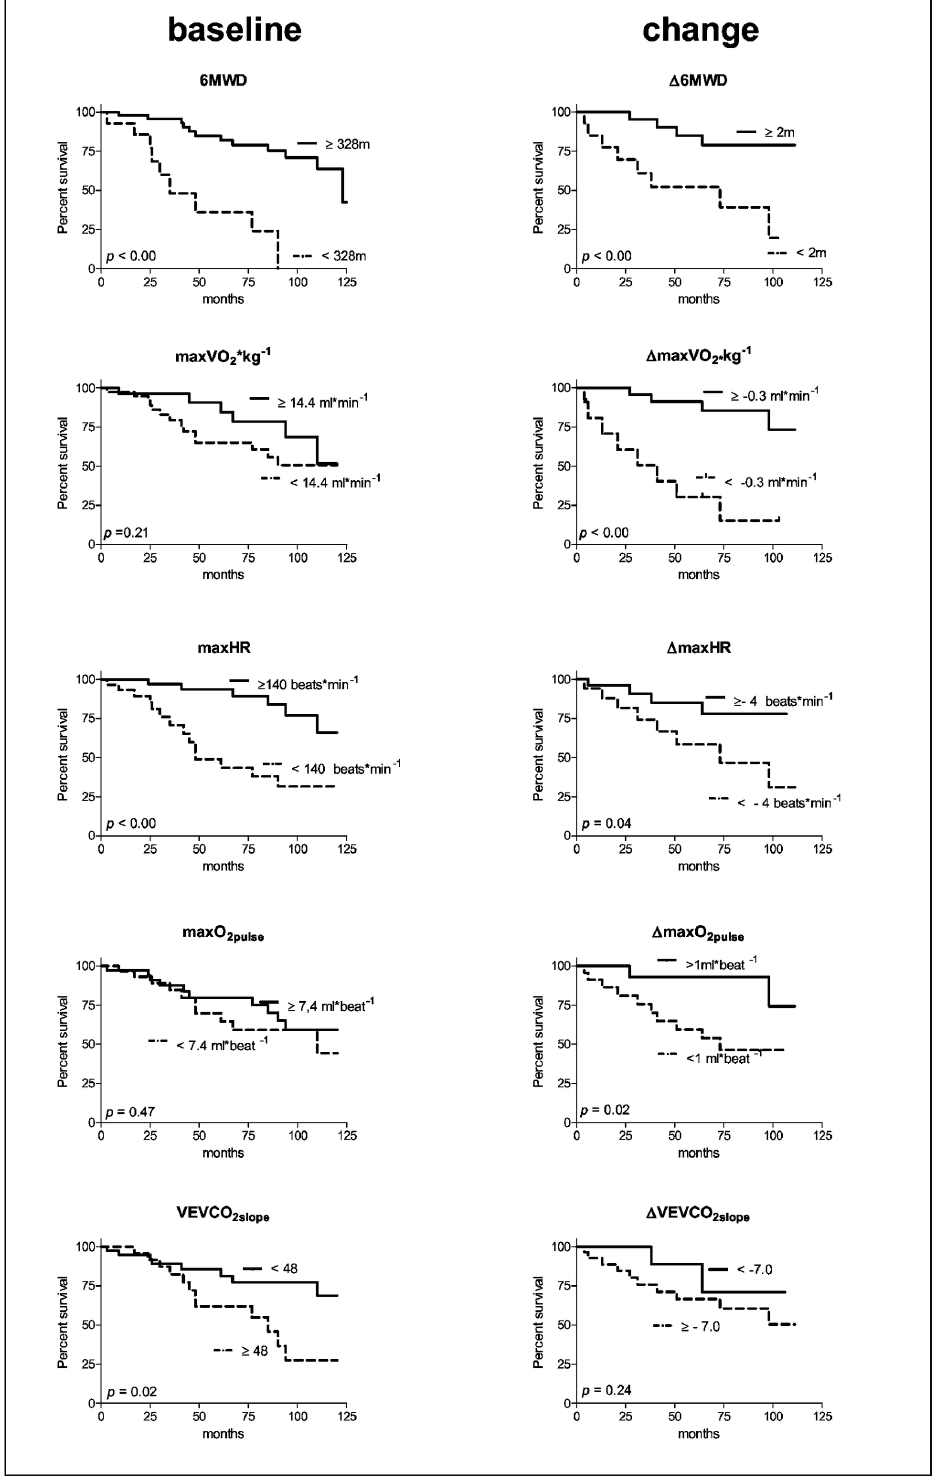
Figure 5. Kaplan-Meier curve’s of baseline exercise variables (left-panels) and changes in exercise variables (Δ) (right panels). 6MWD: six minute walk distance, VO carbon dioxide production. doi: 10.1371/journal.pone.0072013.g005 PLOS ONE |